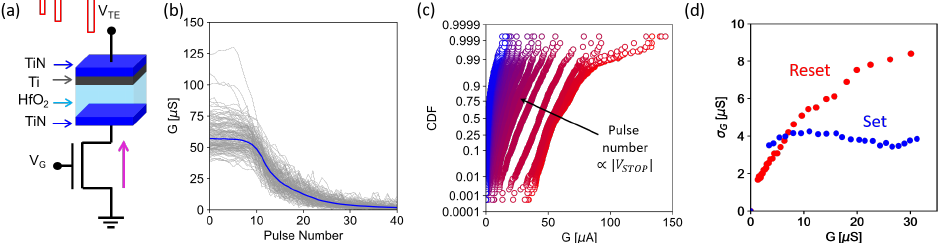
Figure 5. Analog programming with reset pulses. ( a ) Conceptual schematic of the IRPP algorithm. ( b ) Conductance as a function of pulse number for multiple iterations (grey lines) and the average behavior (blue). ( c ) Cumulative distribution function (CDF) of the conductance for increasing stop voltage V STOP . ( d ) Standard deviation of the conductance σ G as a function of the average conductance G for IRPP and IGPP algorithms. Adapted from